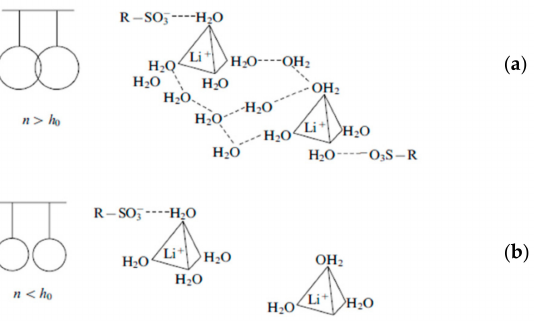
Figure 10. Illustration of hydration of functional groups in the salt forms of MF-4SC membranes by the example of its Li + -form. Reprinted with permission from [39]. Copyright 2002 Springer Nature.